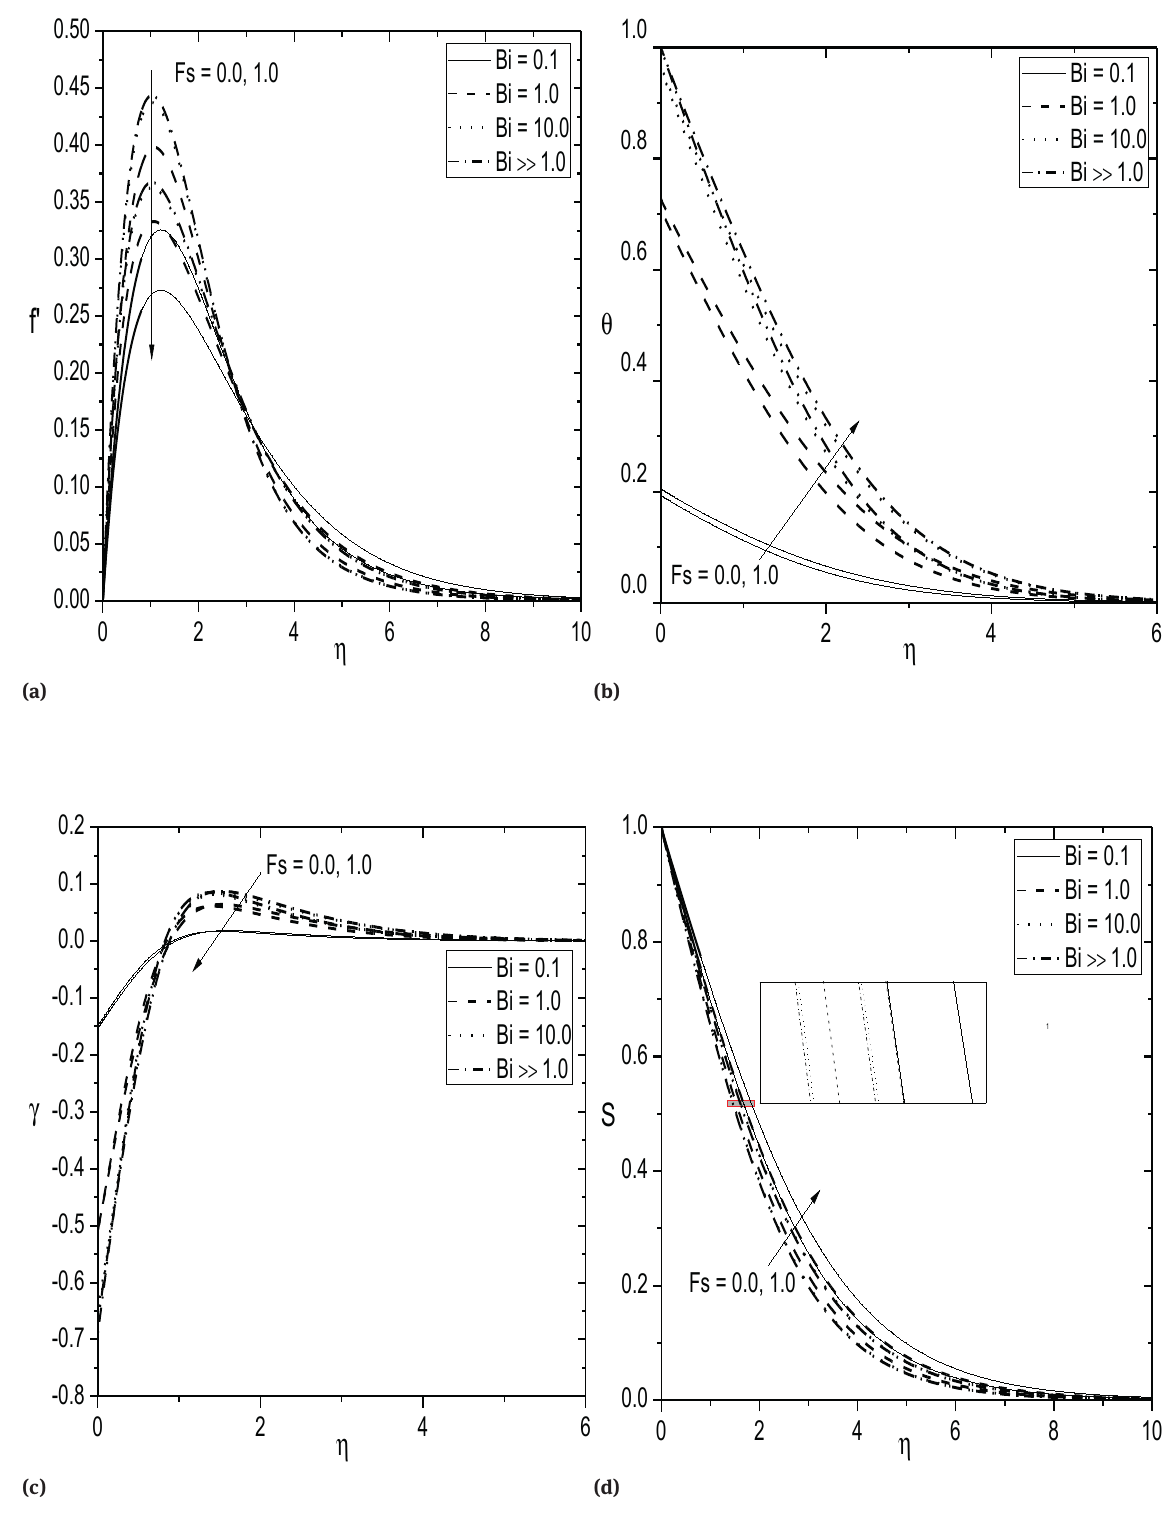
Fig. 4: Effect of Fs and Bi on (a) velocity, (b) temperature, (c) nanoparticle volume fraction, and (d) regular concentration for Ds = 0.2, Dc = 0.3